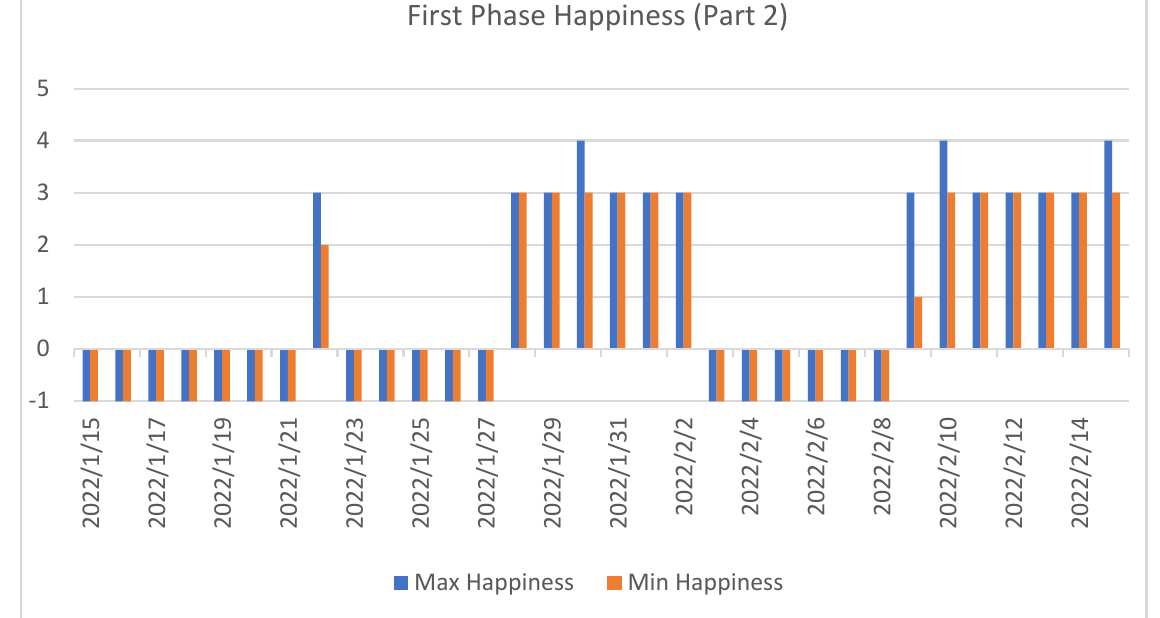
Figure 15. Second set of data from the first phase of the experiment. This figure shows the maximum and minimum happiness values recorded each day for the second subject.